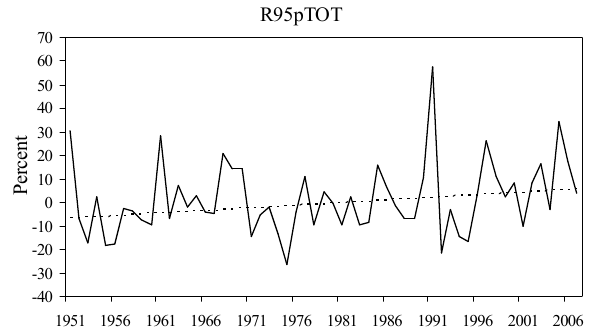
Fig.4. Number of days with Rd>75th (R75p in black) and Rd>95th (R95p in gray) percentile for the Crkvice station for the period 1951-2007. Dashed line indicates Sen’s estimator of the slope.